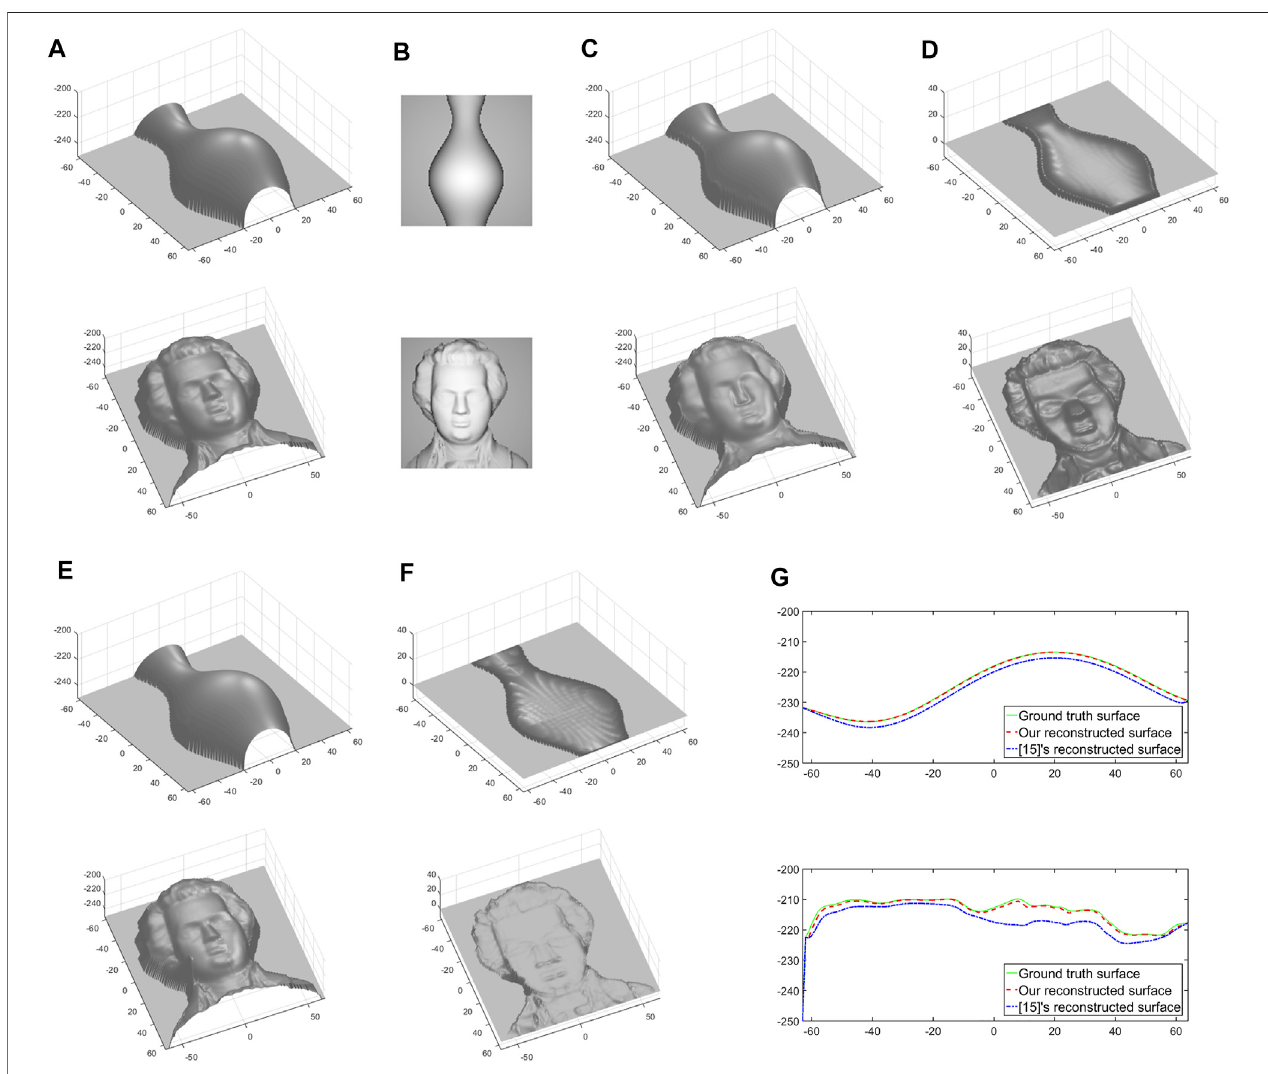
FIGURE2| Experimental resultsonVaseandMozartsurfaces. (A) Groundtruthsurfaces, (B) Syntheticshadingimages, (C) ReconstructedsurfacesbyVogeland Cristiani ’ s approach, (D) Surface errors between (C) and (A) , (E) Reconstructed surface by our proposed approach, (F) Surface errors between (E) and (A) , and (G) Central cross section of ground truth and reconstructed